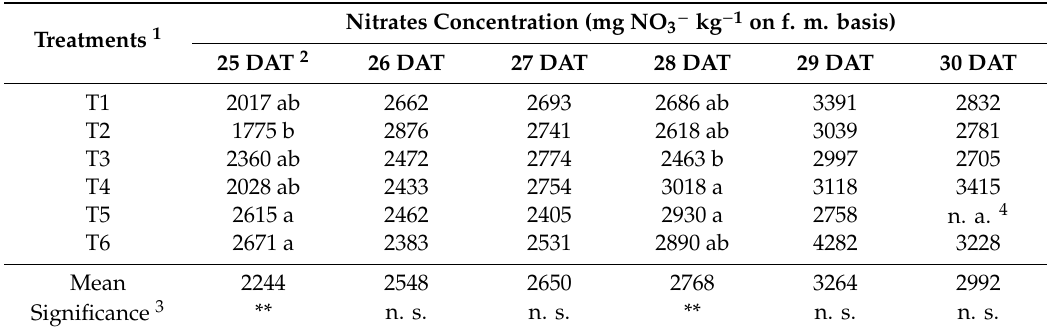
Table 8. Autumn trial: nitrate concentration in lettuce on fresh matter basis. Treatments 1